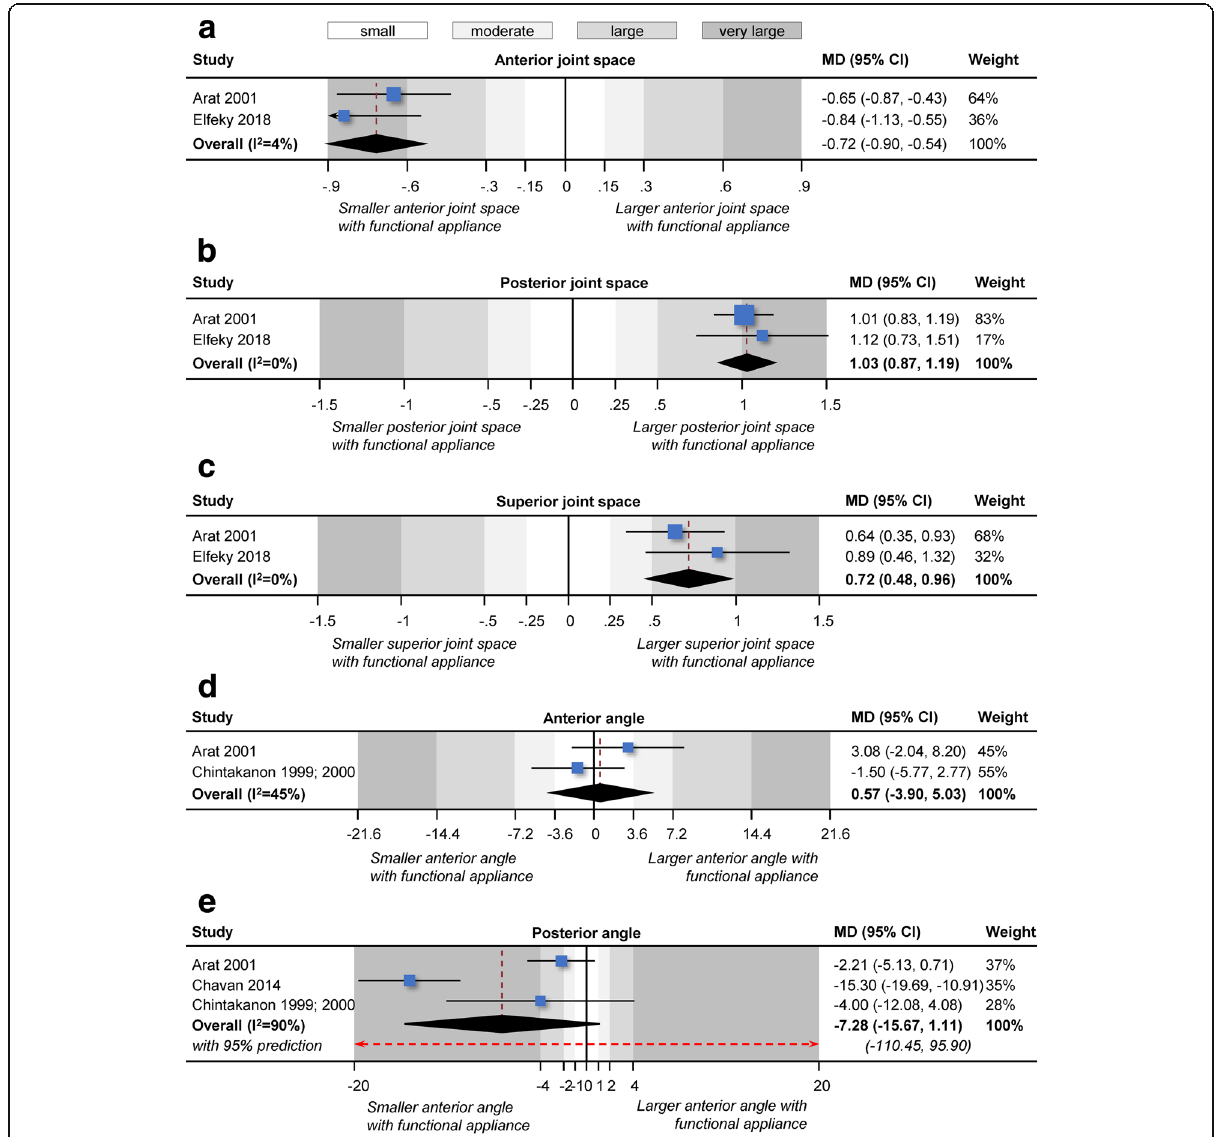
Fig. 3 Contour-enhanced forest plots for random effects meta-analyses comparing functional appliance treatment to no treatment (observation) in terms of changes in a anterior joint space, b posterior joint space, c superior joint space, d anterior angle, and e posterior